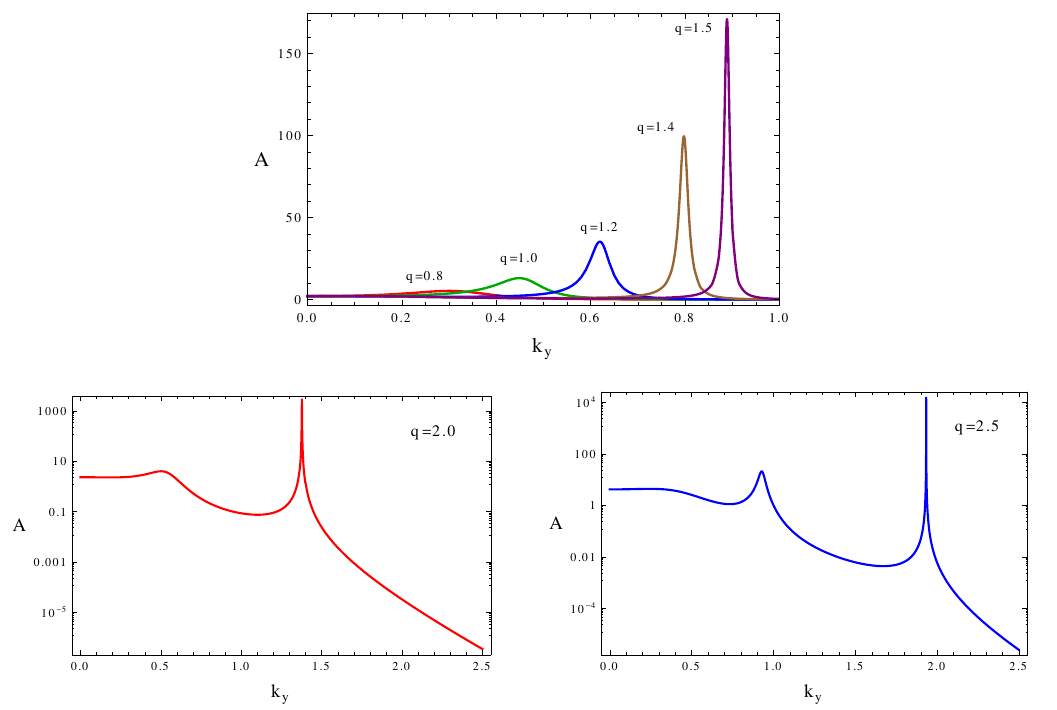
Figure 8 . The MDF as a function of k y at ( k x = 0 ; ! = 10 (cid:0) 6 ) for di(cid:11)erent values of the charge q of the fermion. Note that in the last two plots the vertical axis is logarithmic, and there is a very sharp peak indicative of a Fermi surface. The background geometry is the same as in (cid:12)gure 2 with the ionic lattice amplitude a 0 = 0 : 5 and the wavenumber p =